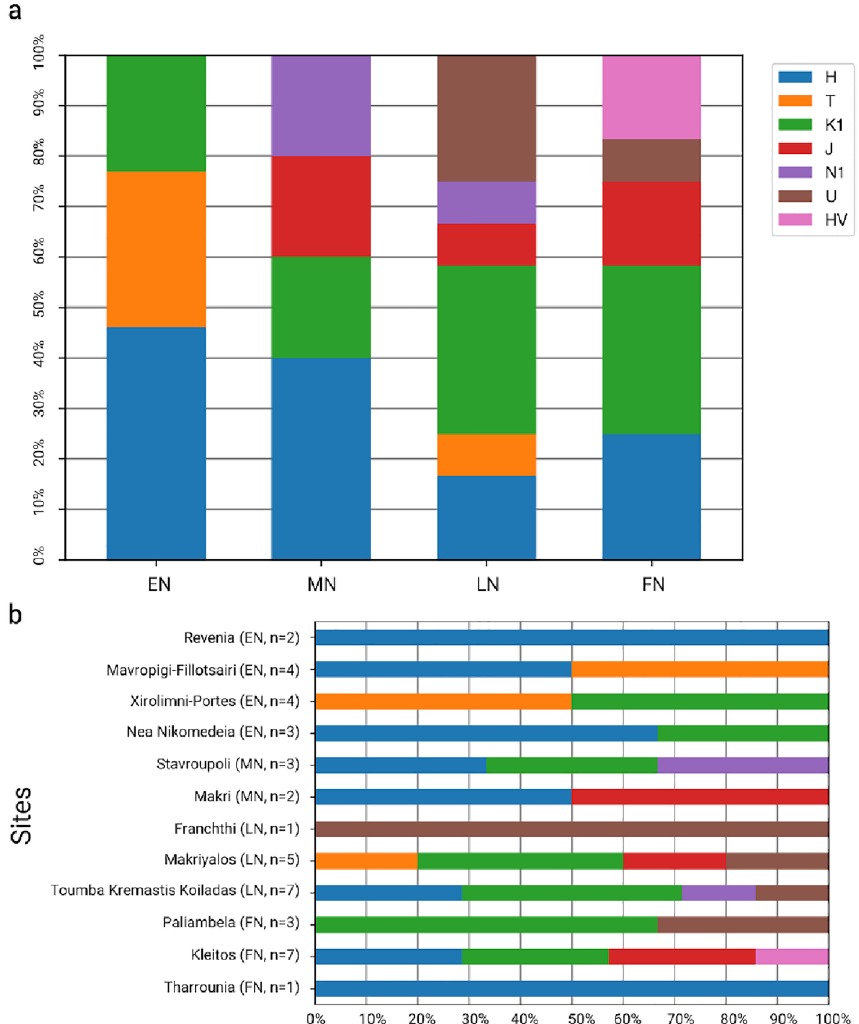
Figure 2. ( a ) Haplogroup frequency at different Neolithic periods in Greece. ( b ) Haplogroup frequency at different Neolithic sites in Greece (EN: Early Neolithic n = 13, MN: Middle Neolithic, n = 5, LN: Late Neolithic n = 13, FN: Final Neolithic n =